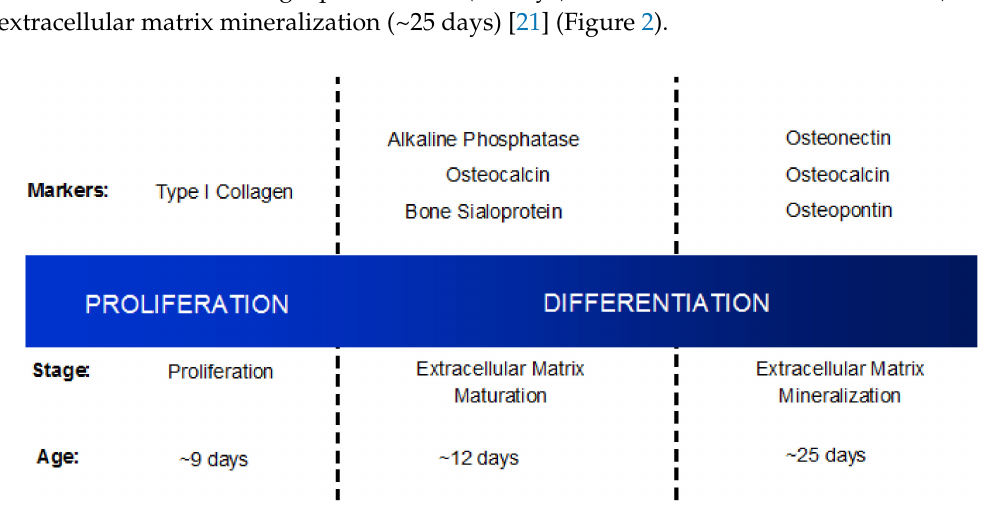
Figure 2. Osteoblast differentiation. Murine osteoblast differentiation is characterized by three stages of growth marked by specific factor expression. During osteoblast proliferation (up to approximately 9 days), osteoblasts produce type I collagen. Osteoblasts enter early differentiation, or extracellular matrix maturation, at approximately 12 days of age, and express the proteins alkaline phosphatase, osteocalcin, and bone sialoprotein. Extracellular matrix mineralization occurs when osteoblasts are approximately 25 days old, where osteoblasts express the proteins osteonectin, osteocalcin, and